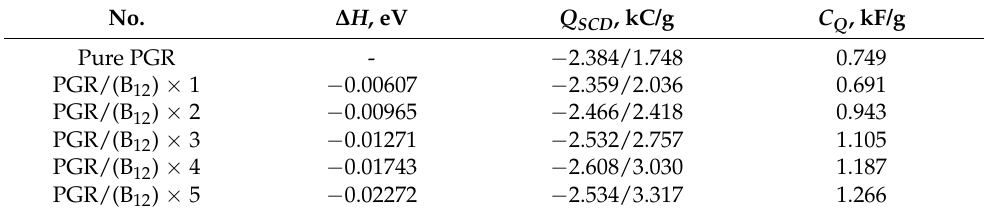
Figure 3. C Q for the pure PGR and for PGR decorated with 1 to 5 boron clusters.